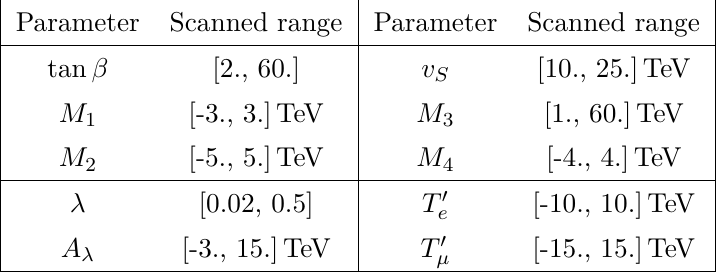
Table 2 . Scanning range of parameter space of the Non-Universal U(1) 0